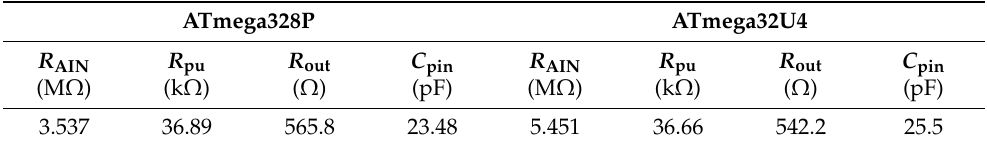
Table 2. Optimized values of the R AIN , R out , R pu and C pin for both ATmega328P and ATmega32U4 AVR ® micro-controllers.